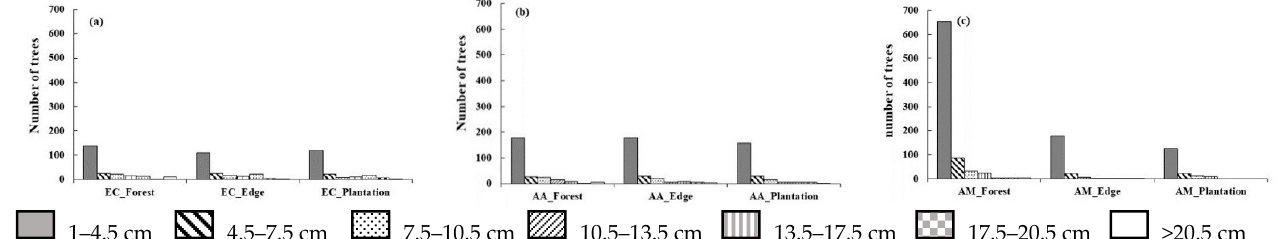
Figure 4. Diameter class distribution in nine stands of three exotic plantations. ( a ) Eucalyptus camaldulensis (EC), ( b ) Acacia auriculiformis (AA), and ( c ) A. mangium (AM) stands. Pioneer species such as Gonocaryum lobbianum , Microcos tomentosa , and Wrightia arborea